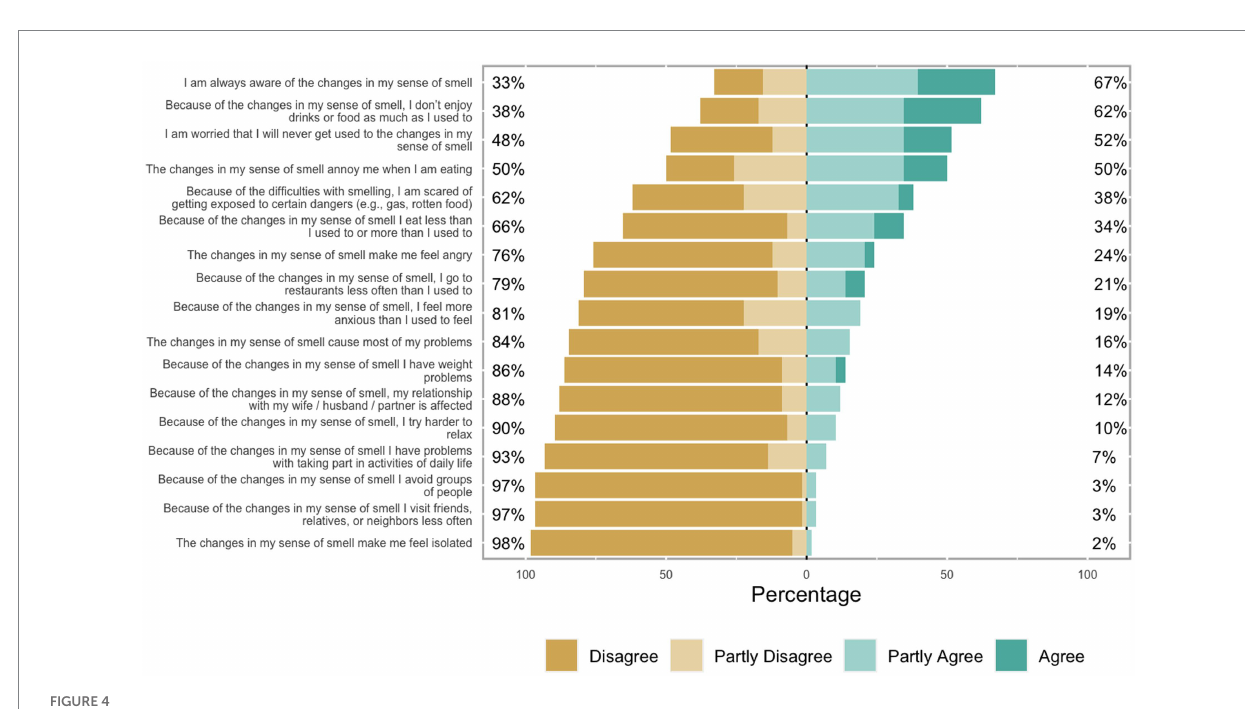
FIGURE 4 Response frequency to the questions of